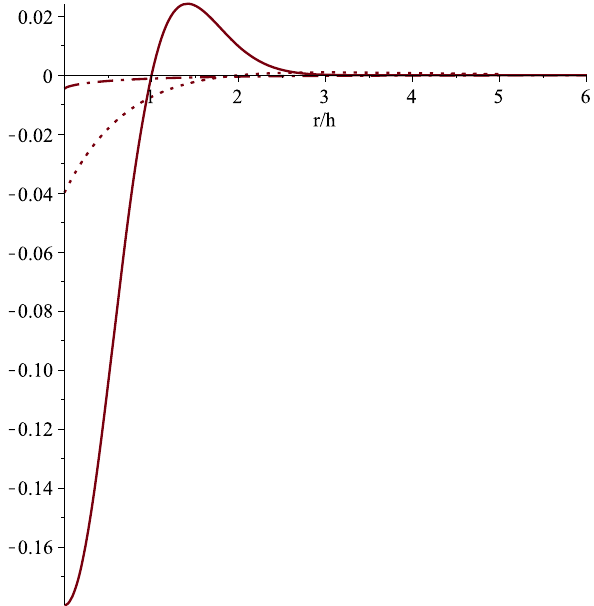
Fig. 2 Plot of h 3 p ⊥ / M defined in (17) for ξ = 1 / 2 (solid line), ξ = 1 (dotted line) and ξ = 1 . 5 (dashdot line). In the DM ( ξ = 7 . 072, h = 2 . 121 × 10 − 9 kpc and M = 4 . 57 × 10 9 M (cid:8) [29,30]) we have | p ⊥ ( 0 ) | ≈ 5 . 8 × 10 − 41 m − 2 (geometric units) or equivalently, | p ⊥ ( 0 ) | ≈ 7 × 10 3 N/m 2 (SI units). Note that p ⊥ changes sign at r 0 ≈ 0 . 3 kpc which is situated well inside the Narrow Line Region of an Active Galactic Nuclei (100 pc–4 kpc)